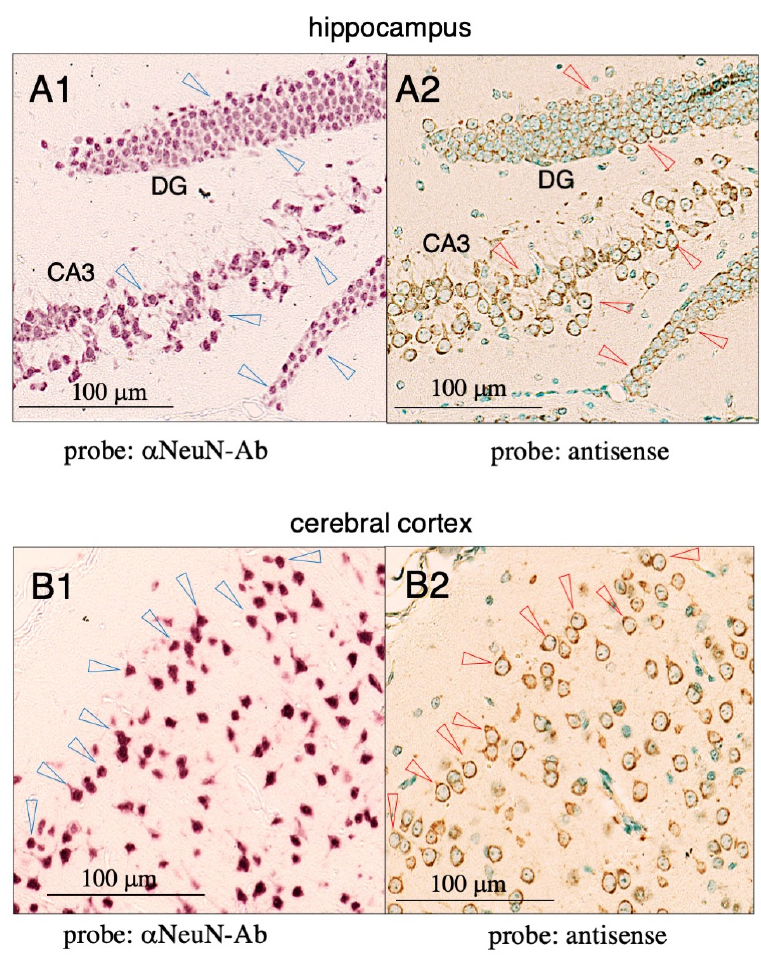
Figure 2. In situ hybridization of mouse cortex and hippocampus using a Tf-antisense probe and immunohistochemistry with an anti-NeuN antibody. Pairs of mirror-image sections of mouse cortex and hippocampus were prepared: one section was stained with anti-NeuN antibody for detecting neurons ( A1 , B1 ) (violet) and the other with antisense probe and methyl green for nuclear staining ( A2 , B2 ). The antisense probe was detected with horseradish peroxidase-conjugated anti-DIG antibody (brown). Some NeuN-positive cells are indicated with blue arrowheads ( A1 , B1 ) and the same positions on the mirror-image section are indicated with red arrowheads on antisense-stained sections ( A2 , B2 ).